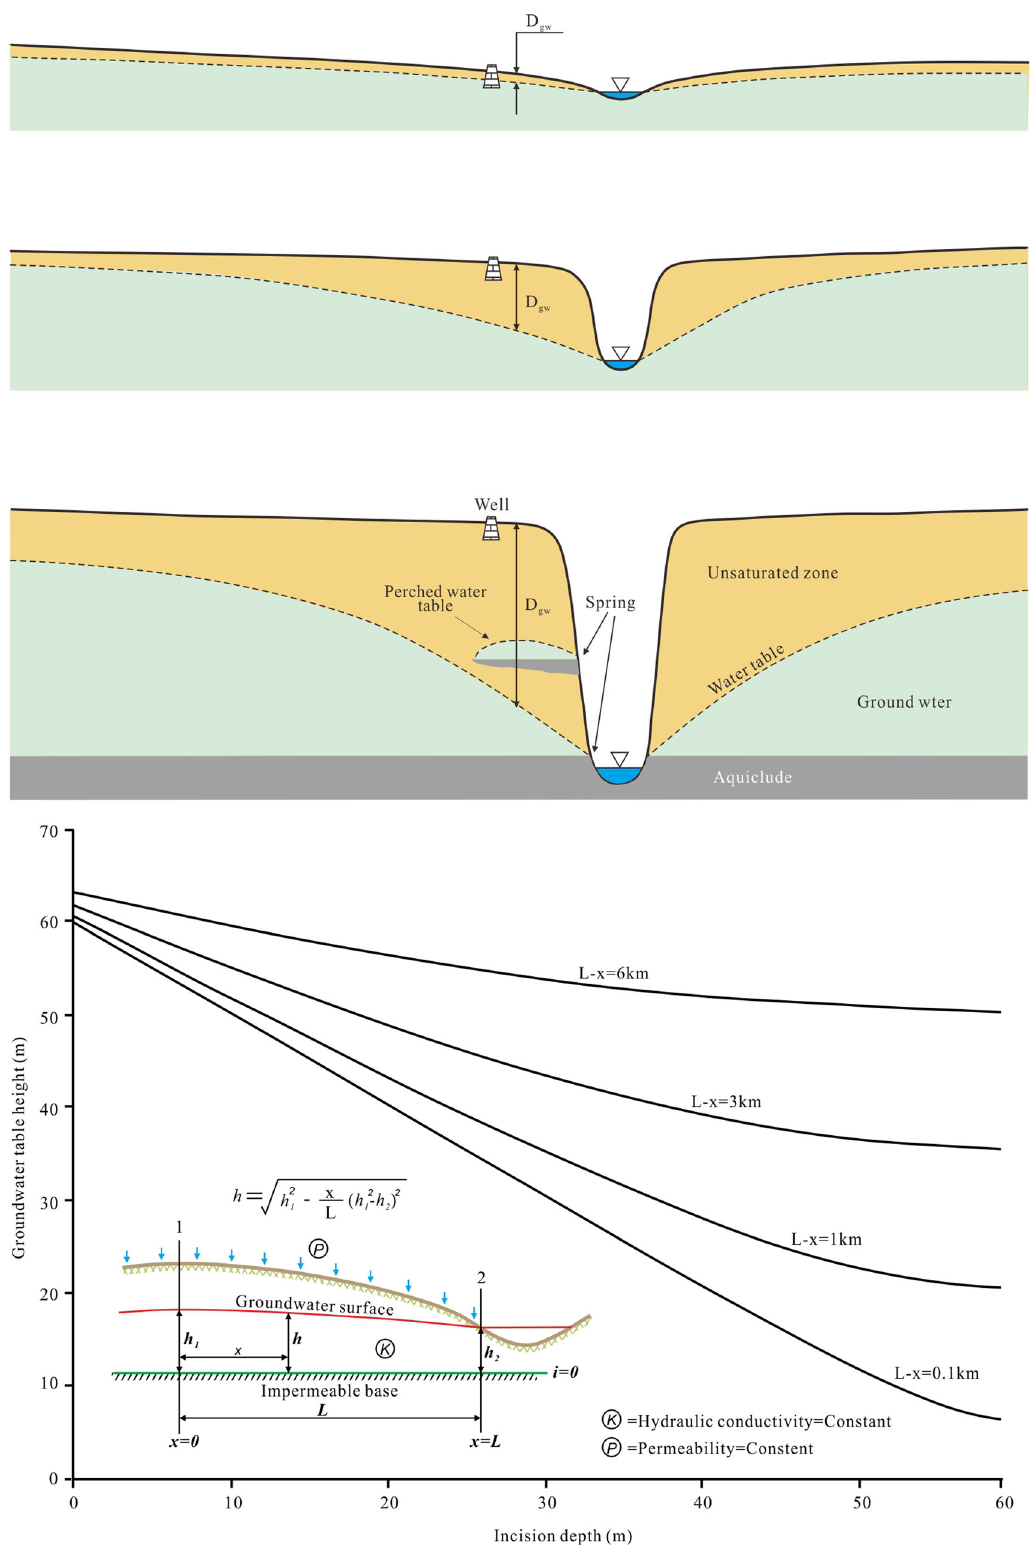
Fig. 6 Model-based estimation of ground water drops due to river incision. Groundwater drops depending on the degree of incision. D gw (the riparian depth to groundwater) is greatest near the stream channel and shallower in more distal fl oodplain regions.